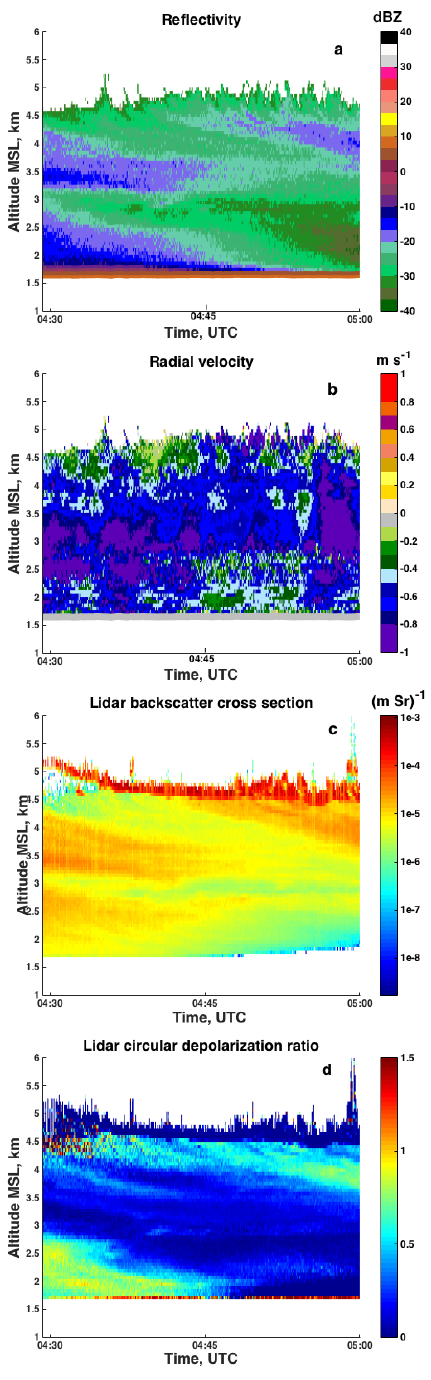
Figure 13. Coincident ground-based HCR and HSRL measure- ments of liquid and ice clouds. (a) W-band reflectivity, (b) W-band radial velocity, (c) lidar backscatter and (d) lidar circular depolar- ization ratio. Data were collected on 22 November 2013.